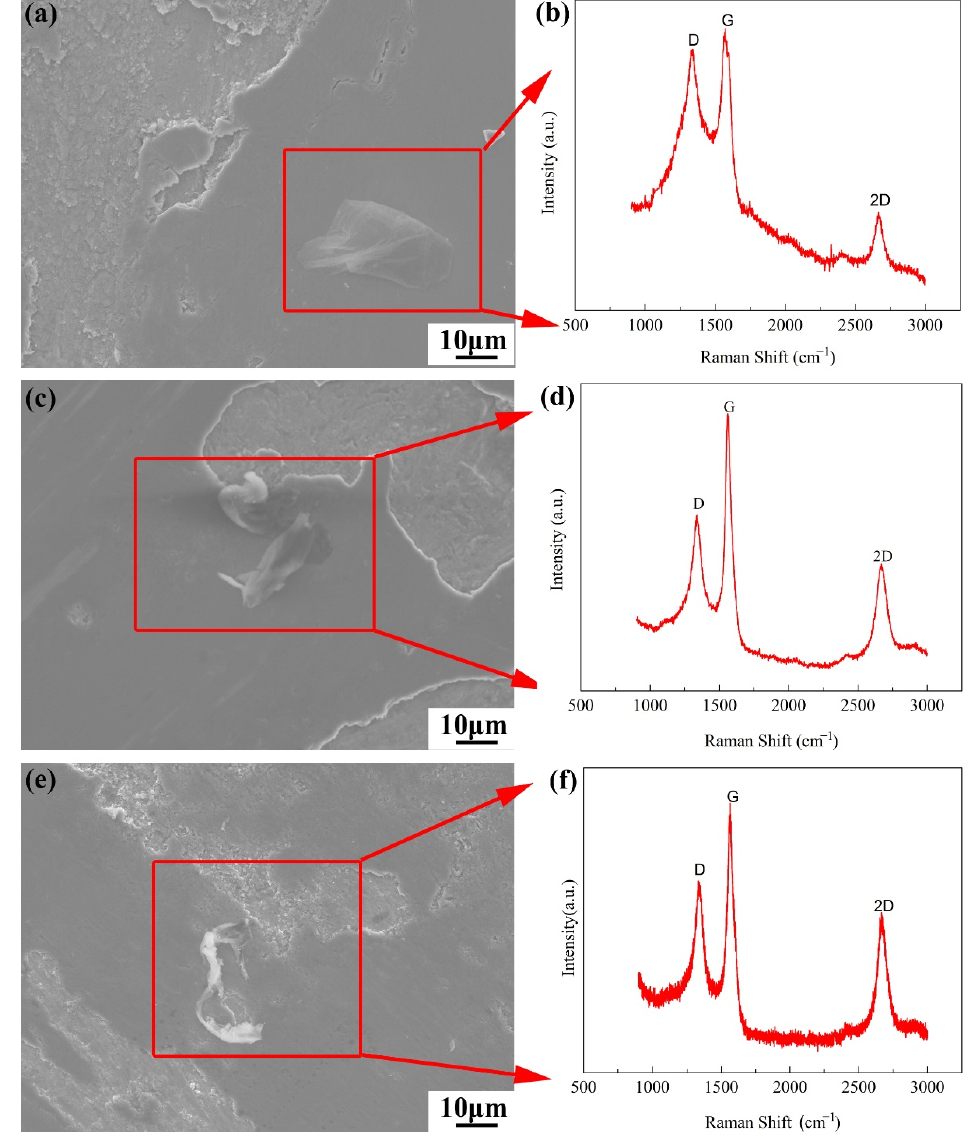
Figure 10. SEM images and corresponding Raman results of GNPs in nickel-based composite coatings with different NiGNPs content: ( a , b ) 10%, ( c , d ) 20%, ( e , f ) 30%.